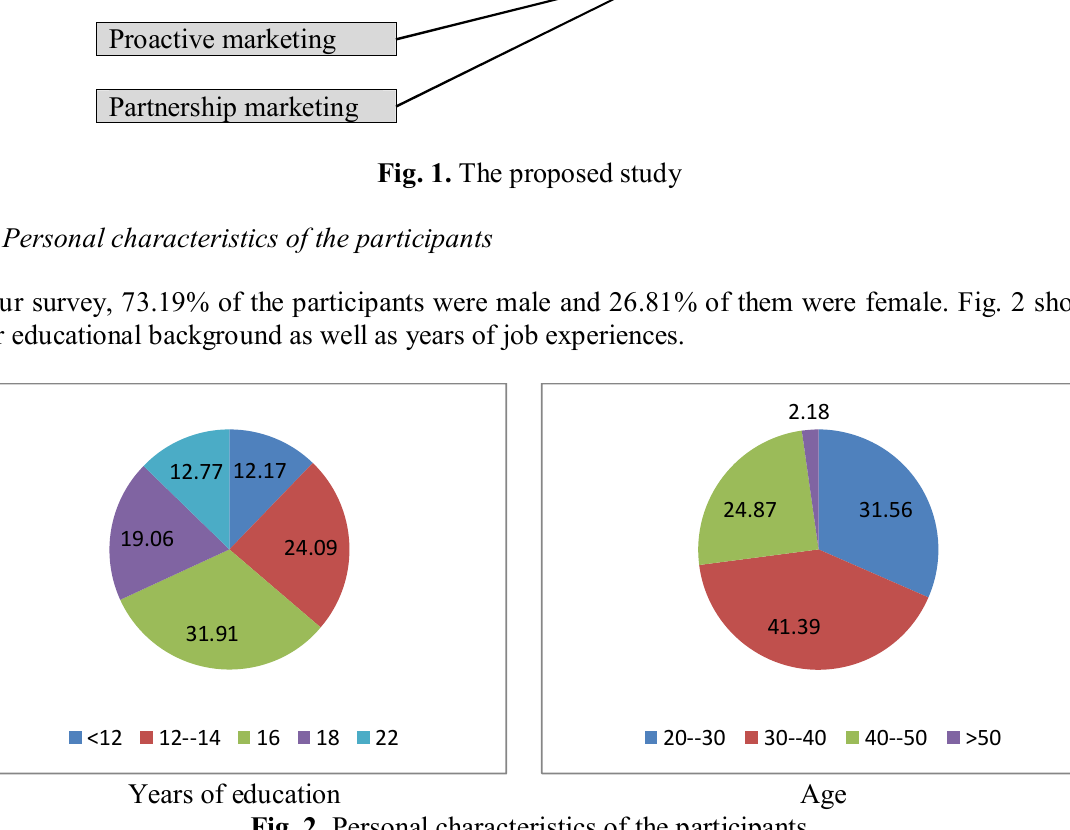
Fig. 2. Personal characteristics of the